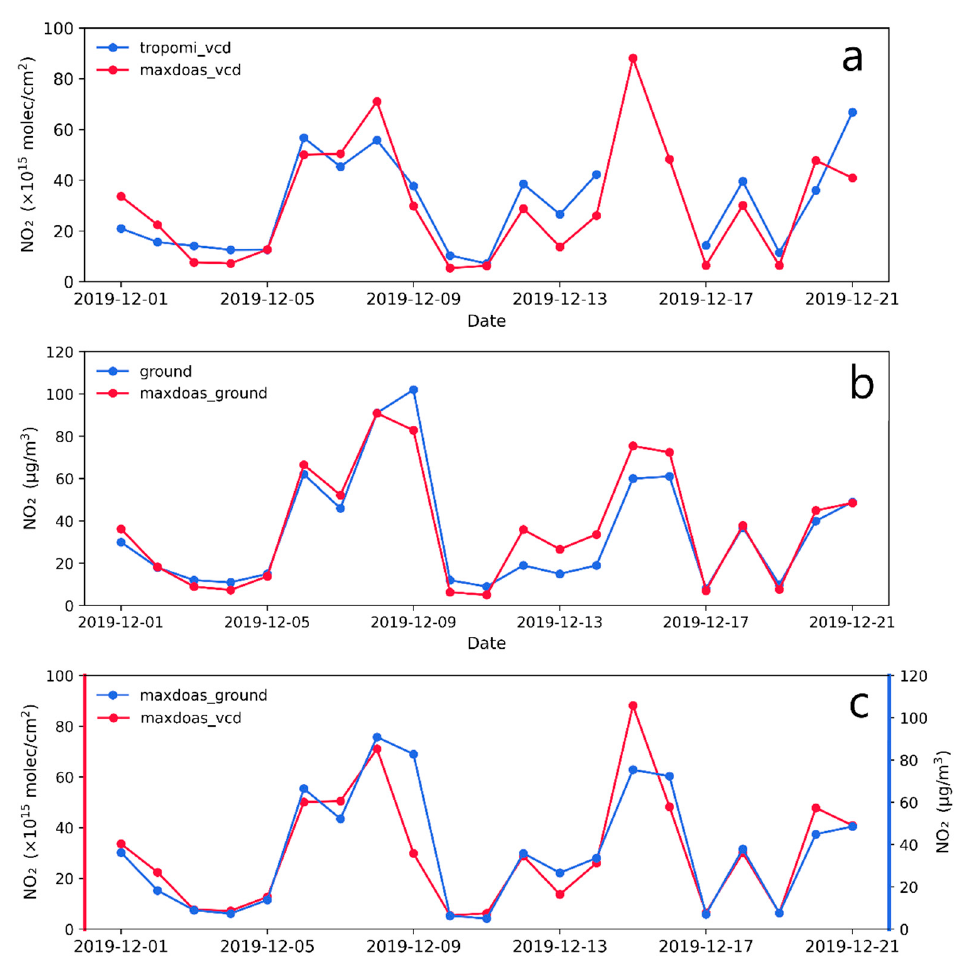
Figure 3. NO 2 comparison time series in Beijing. ( a ) TROPOMI TVCD and MAX-DOAS, ( b ) 1006A and MAX-DOAS, ( c ) MAX-DOAS comparison.